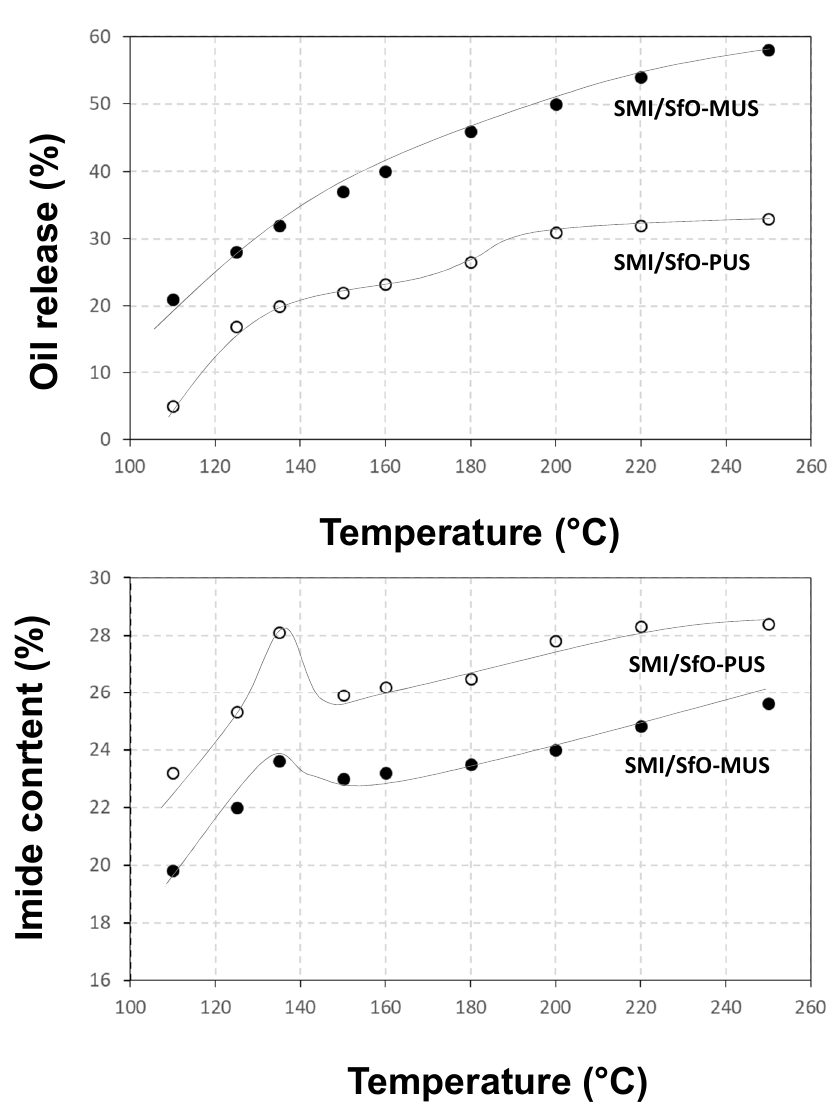
Figure 6. Quantification of chemical characteristics of SMI/SfO-PUS and SMI/SfO-MUS coatings after thermal oil release based on single-point Raman spectra: ( a ) thermal oil release profiles, ( b ) variations in imide